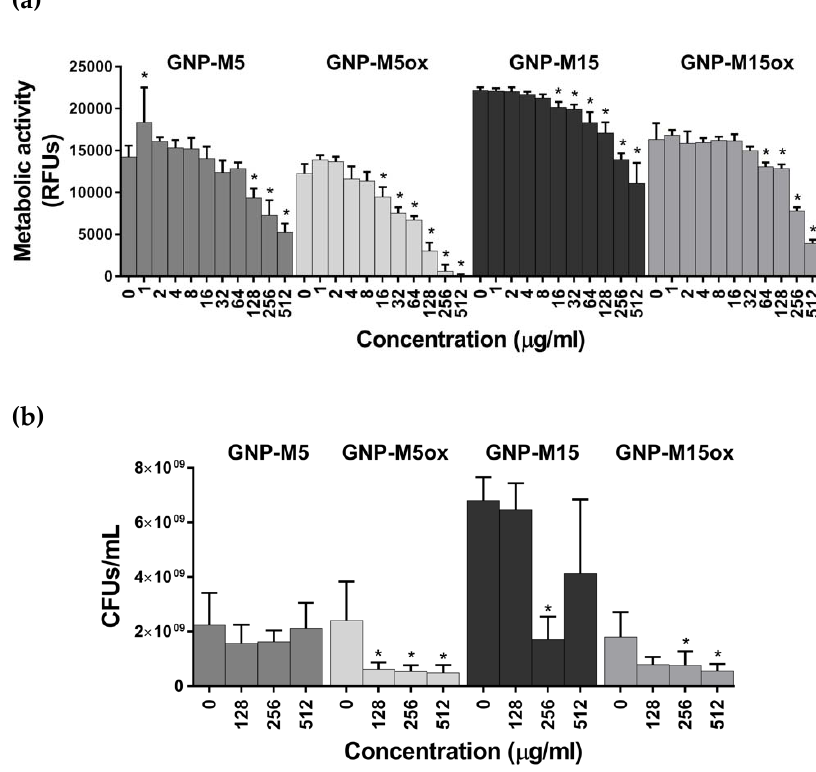
Figure 2. Antibacterial activity of GNP dispersions: ( a ) metabolic activity determined by resazurin assay and ( b ) bacteria viability of S. epidermidis determined by viable cell count after 24 h incubation with GNP ‐ M5, GNP ‐ M5ox, GNP ‐ M15 and GNP ‐ M15ox aqueous dispersions. * Statistically significantly different from control (one ‐ way ANOVA (A) and Kruskal–Wallis (B); p ≤ 0.05).